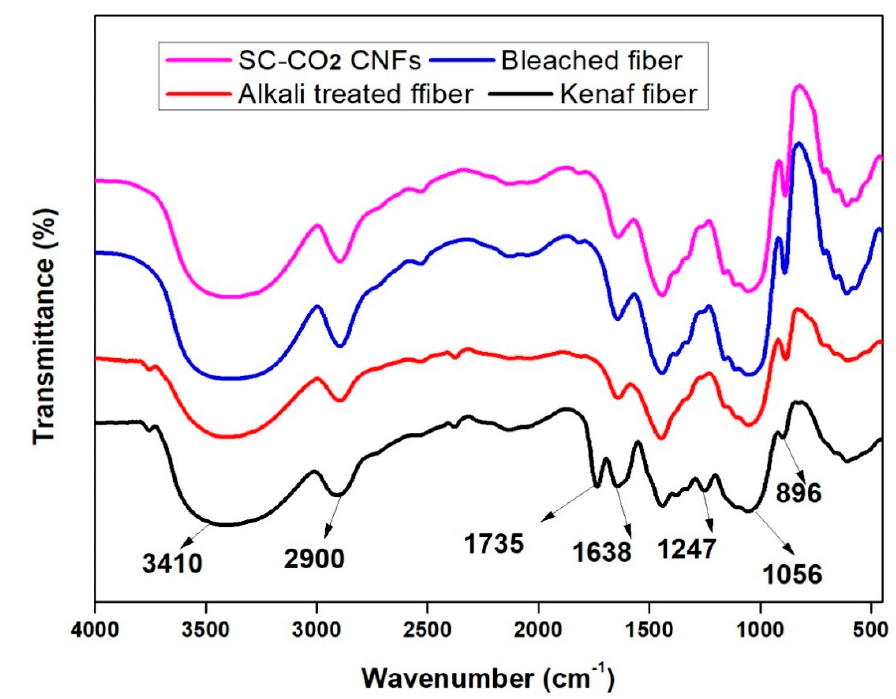
Figure 2. Showing the Fourier transmission infra-red (FTIR) of ( a ) raw kenaf fiber, ( b ) alkaline treated kenaf fiber, ( c ) bleached kenaf fiber, and ( d ) SC-CO 2 extracted CNFs.